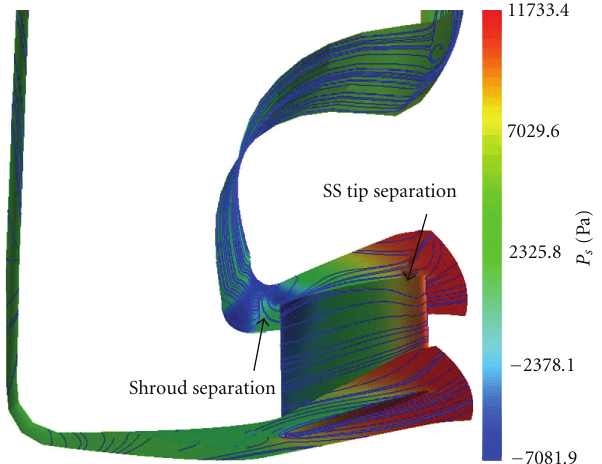
Figure 7: Flow traces near impeller B#1 surfaces.